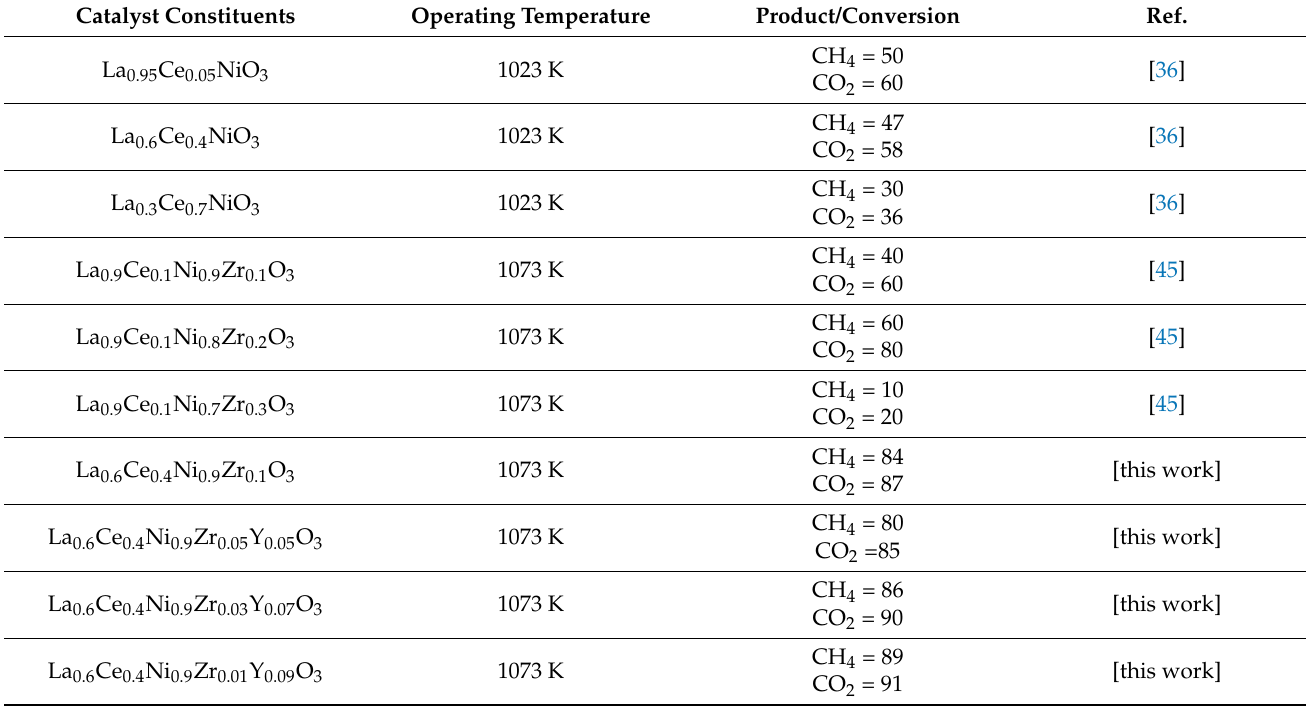
Table 4. Comparison of the results of this work with those of the